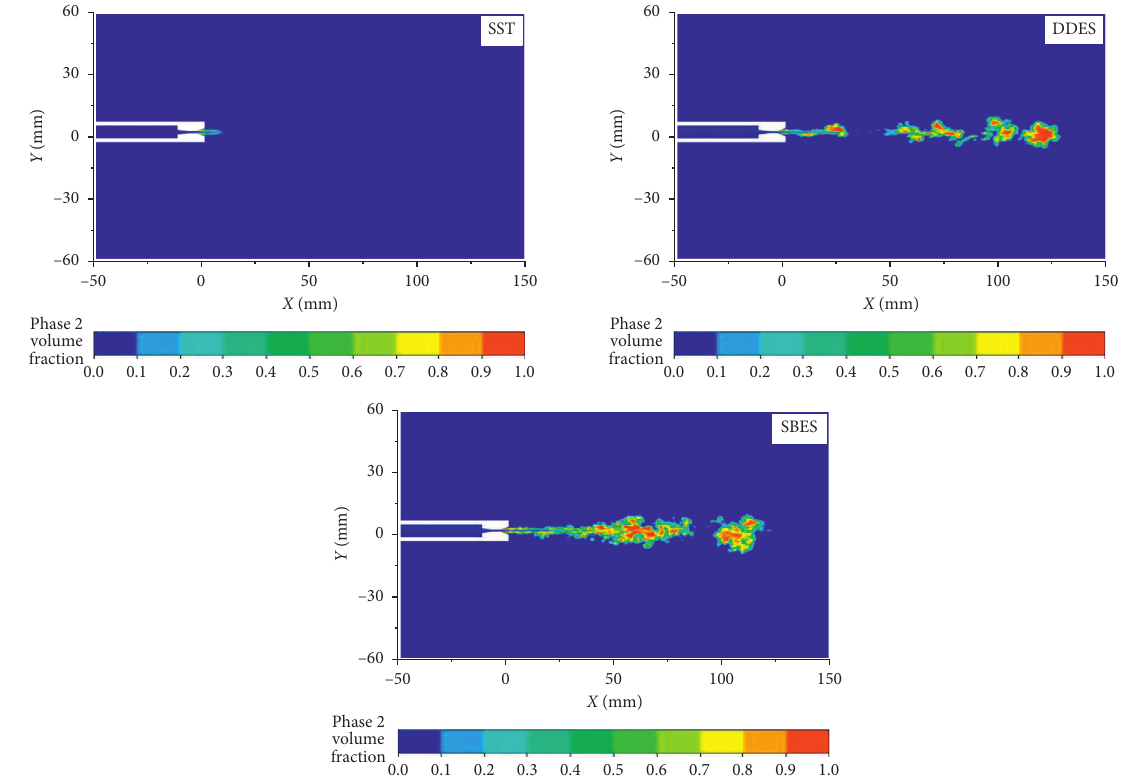
Figure 6: Vapor volume fractions by different turbulence models.